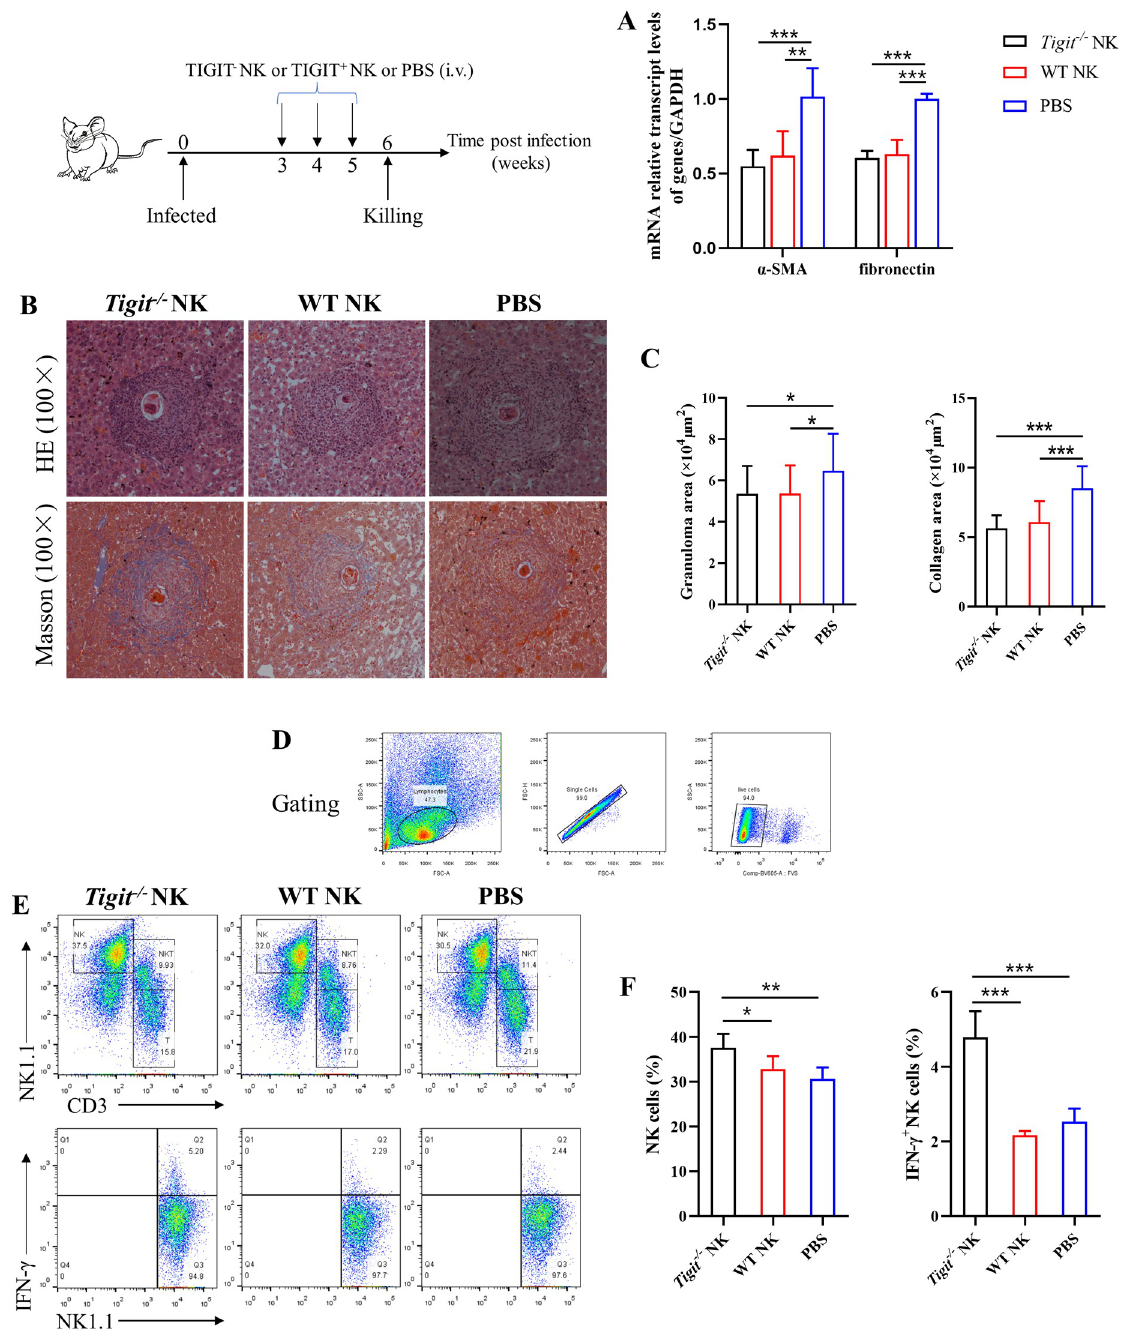
Fig 6. Tigit regulates the natural killer (NK) cell population and function of schistosomiasis-induced liver fibrosis. (A) Relative mRNA transcript levels of α -SMA and fibronectin in the Tigit -/- NK cell and WT NK cell adoptive transfer groups and control (phosphate-buffered saline [PBS]) group at 6 weeks post infection. (B) Hematoxylin-eosin (HE) and Masson staining of liver tissues in the Tigit -/- NK cell group, WT NK cell group, and control group at 6 weeks post infection. (C) At 6 weeks post infection, areas of liver granulomas and collagen deposition in the Tigit -/- NK cell group, WT NK cell group, and control group. (D) Circle gating strategy for lymphocytes, single cells, and live cells in hepatic non-parenchymal cells. (E and F) Flow cytometry results and bar graphs of the proportion of hepatic NK cells and IFN- γ + NK cells in each treatment group. All data are presented as mean ± standard deviation at least three independent experiments. � P < 0.05, �� P < 0.01, ��� P < 0.001.